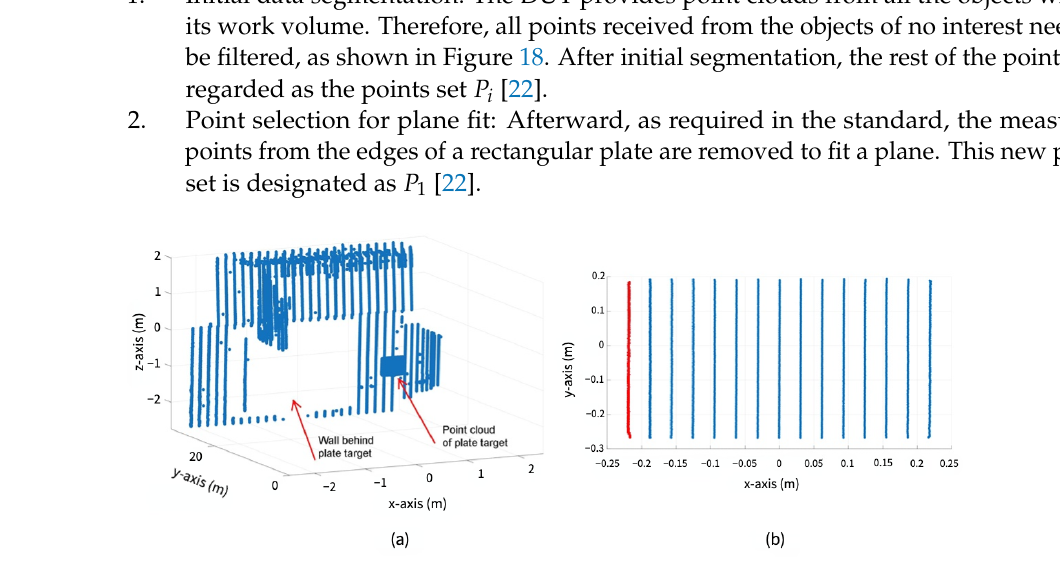
Figure 18. Initial data segmentation. ( a ) Raw point cloud data from every object within the FoV of DUT. ( b ) Refined data P i representing point cloud of plate target. The red dotted points are removed from the edges of the rectangular plate as the standard recommends. The effective width W and length L become 400mm ×